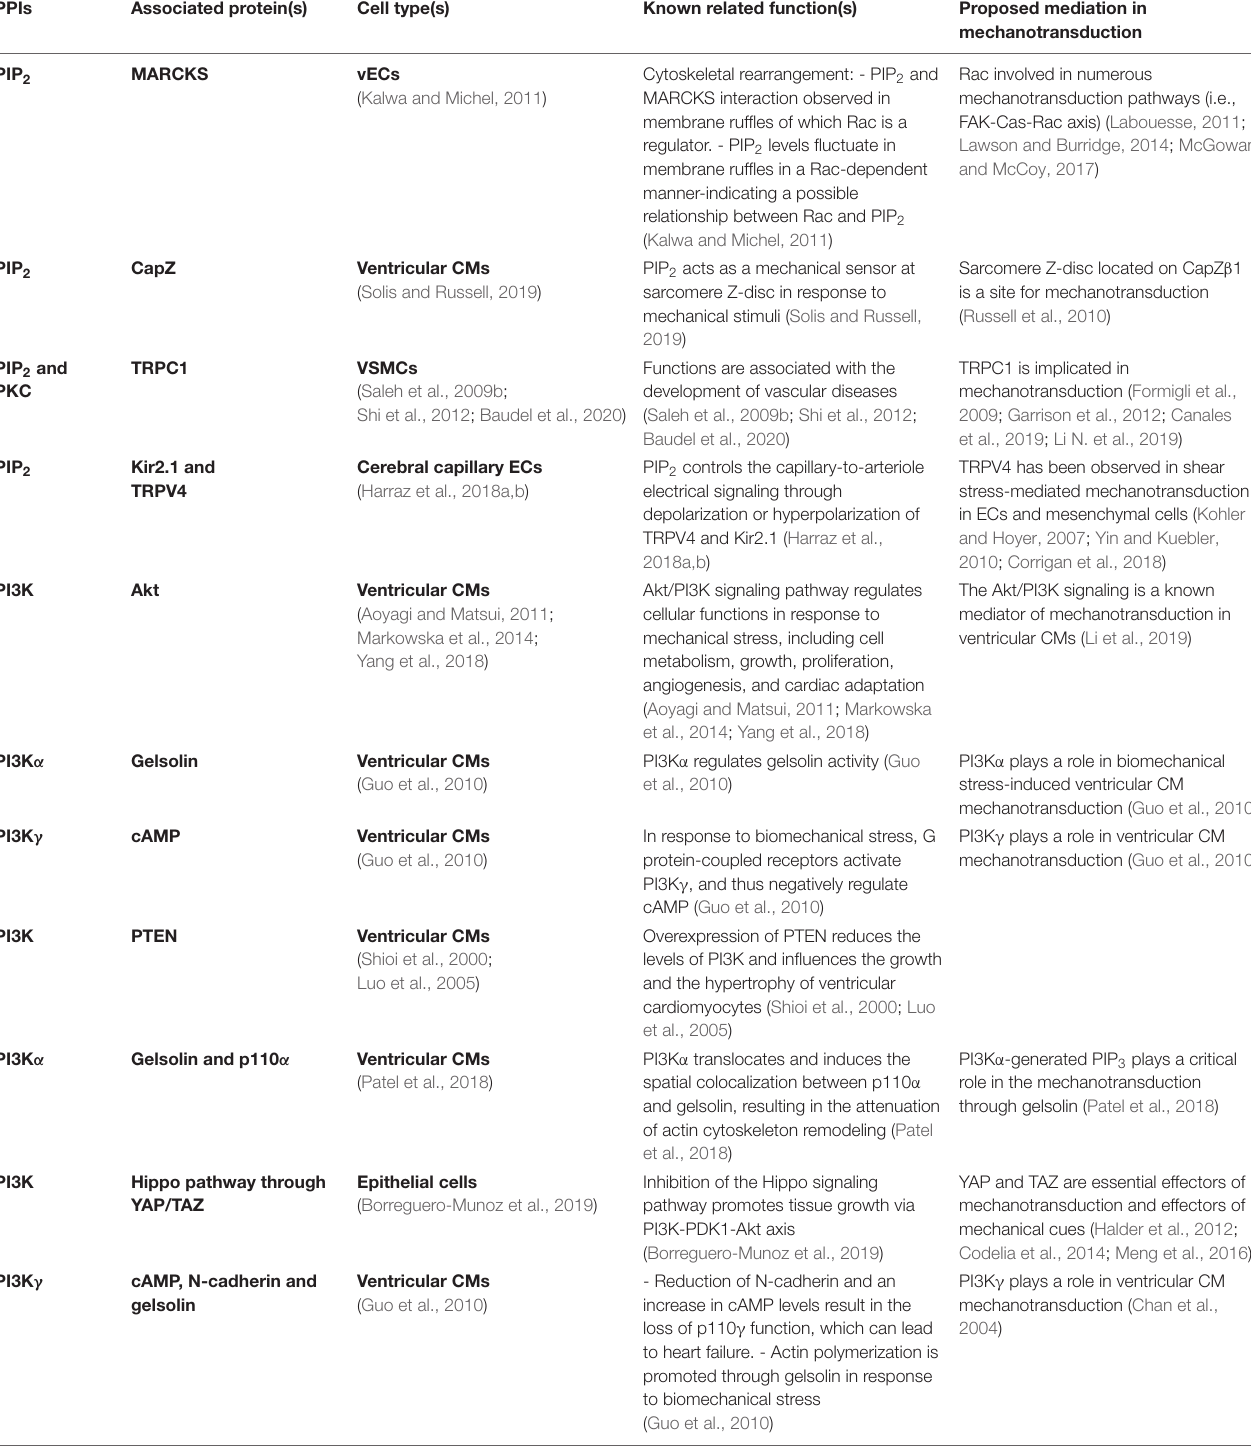
TABLE 1 | Overview of phosphoinositide signaling and mechanotransduction in cardiovascular biology and